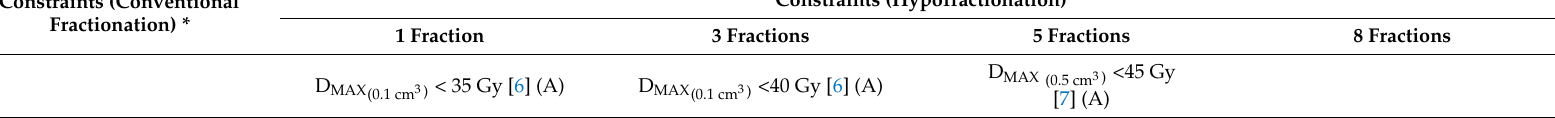
Organ Constraints (Conventional Fractionation)